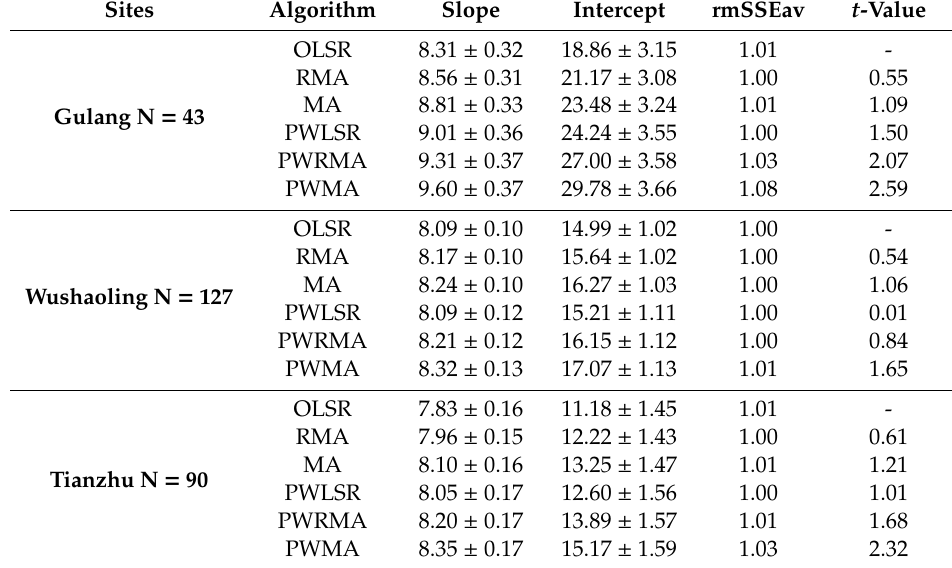
Table 5. Parameters of the fit for OLSR (ordinary least squares regression), RMA (reduced major axis regression), MA (major axis regression), PWLSR (precipitation weighted least squares regression), PWRMA (precipitation weighted reduced major axis regression), PWMA (precipitation weighted major axis regression) regressions at each site in the Qilian